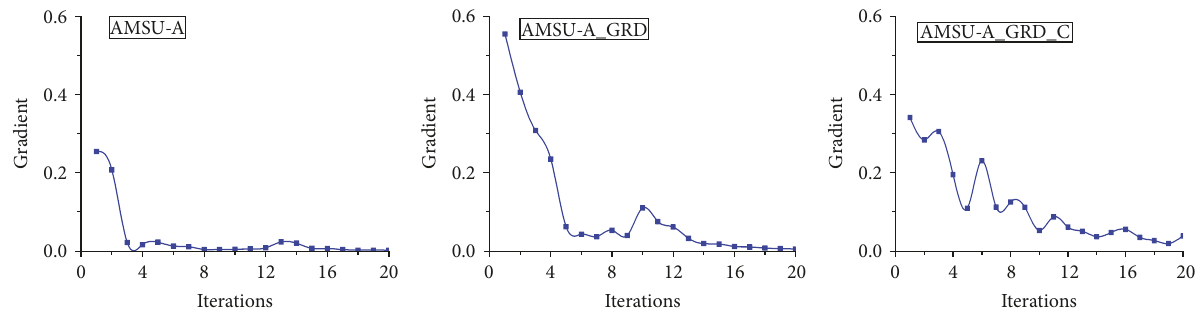
Figure 3: Variations of gradient terms with respect to iterations for ideal